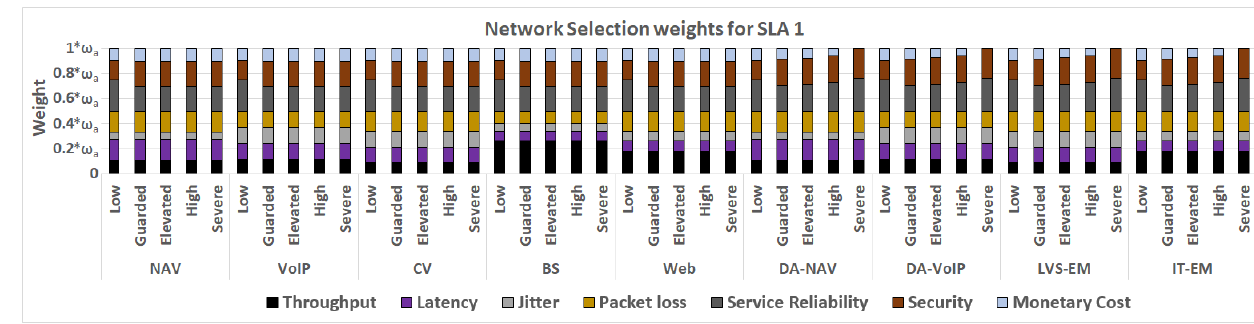
Figure 16. Network selection weights for